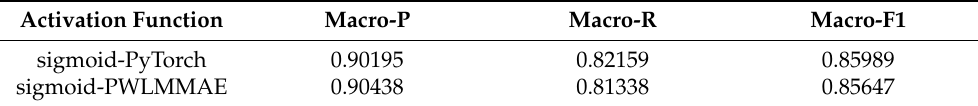
Table 2. Evaluate Table 2. Evaluate sigmoid.